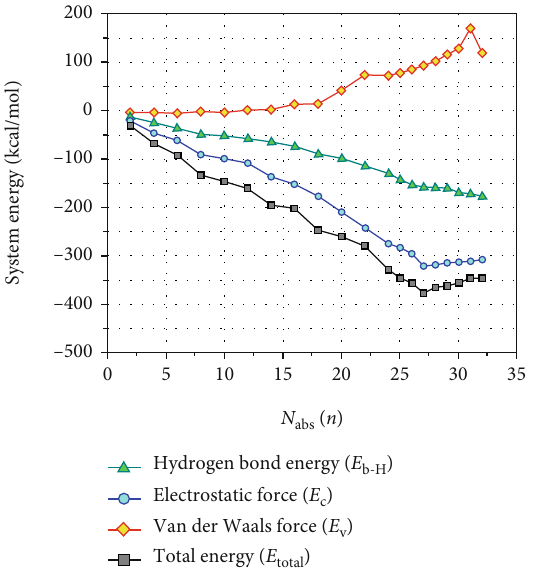
Figure 8: Energy changes during unit cell adsorption of di ff erent amounts of H O 2